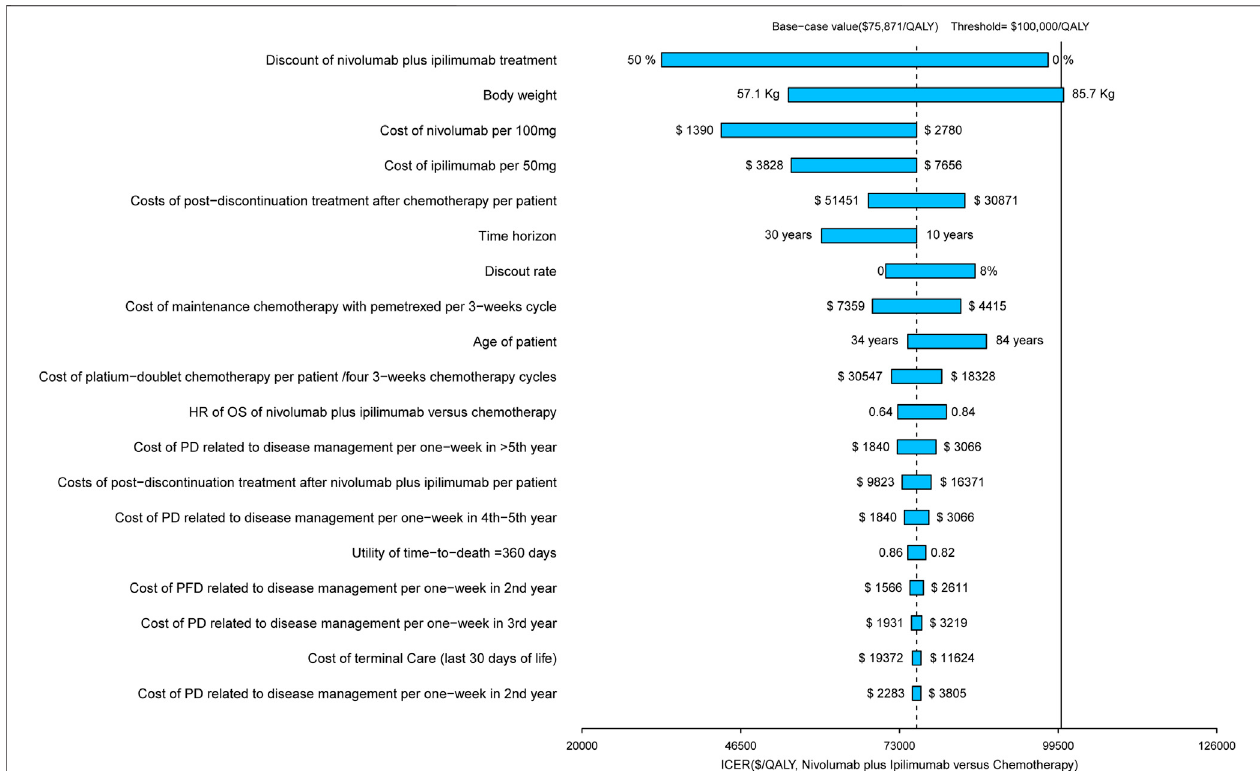
FIGURE 3 | Tornado diagram of one-way sensitivity analyses of nivolumab plus ipilimumab vs. chemotherapy in the context of United States.